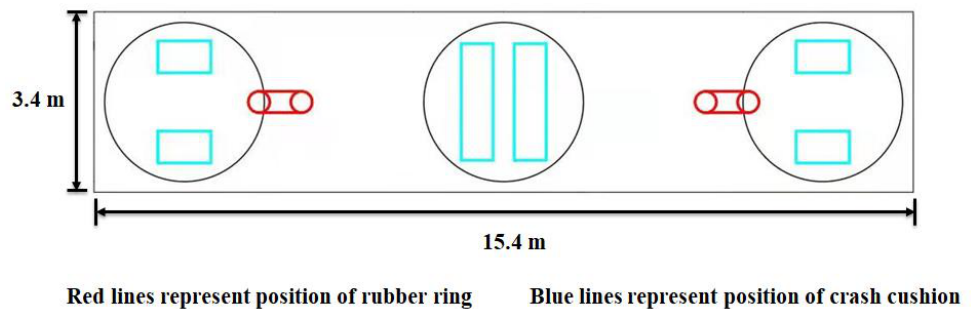
Figure 3. Schematic diagram of connecting structure at one end of adjacent floating breakwater modules.